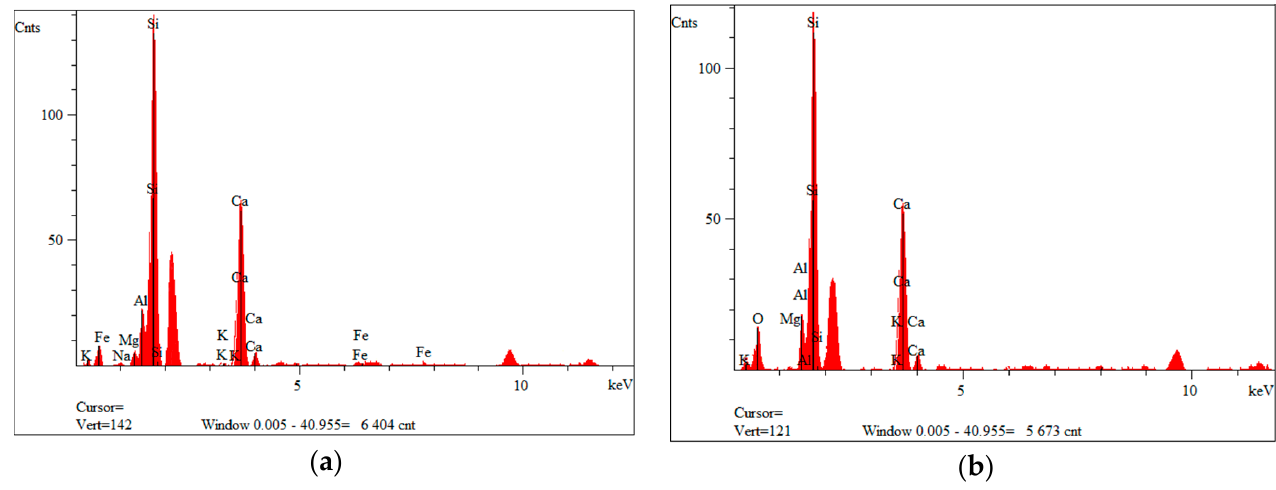
Figure 8. EDS analysis of fraction III from wind turbines: ( a ) for point 3 of Figure 7b; ( b ) for point 5 of Figure 7b.